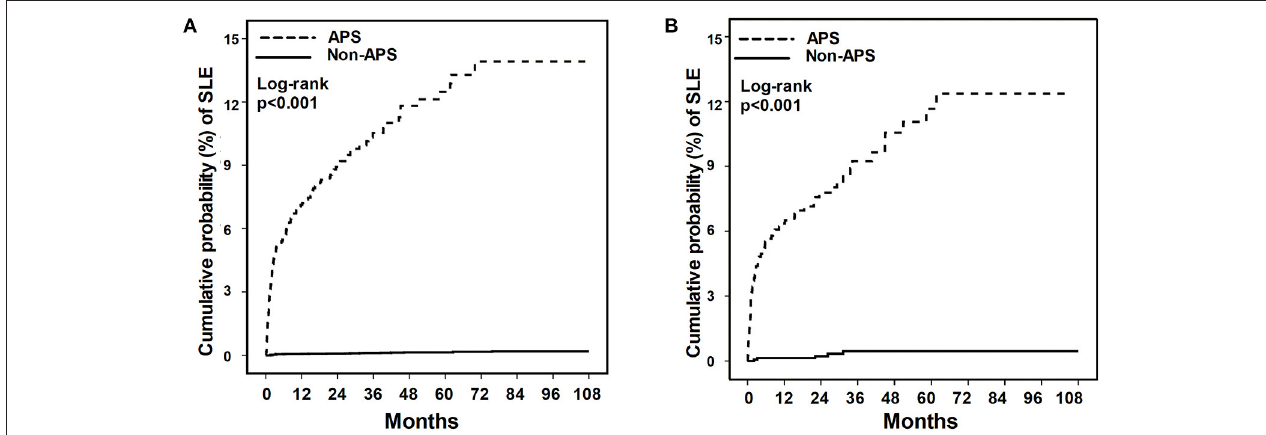
FIGURE 2 | The cumulative incidence of SLE for patients with and without APS. (A) age- and sex-matched population. (B) Propensity score-matched population. APS, anti-phospholipid syndrome; SLE, systemic lupus erythematosus.